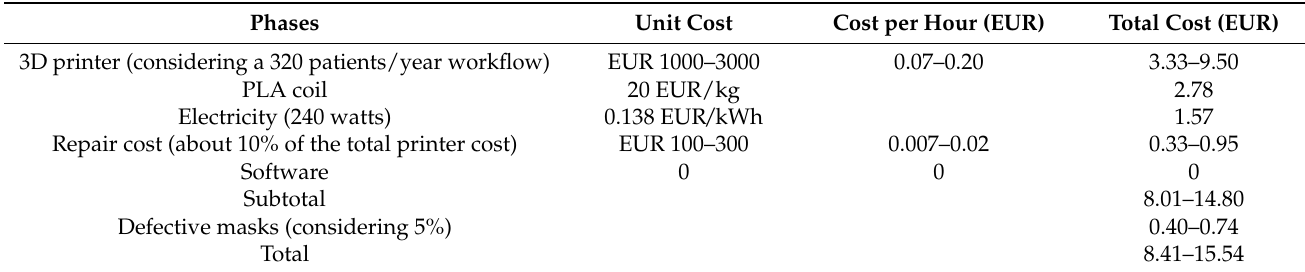
Table 7. Cost analysis of 3D printing a mask with a thickness of 2 mm and 50% infill, weighing 139.02 g, for 47 h and 32 min.